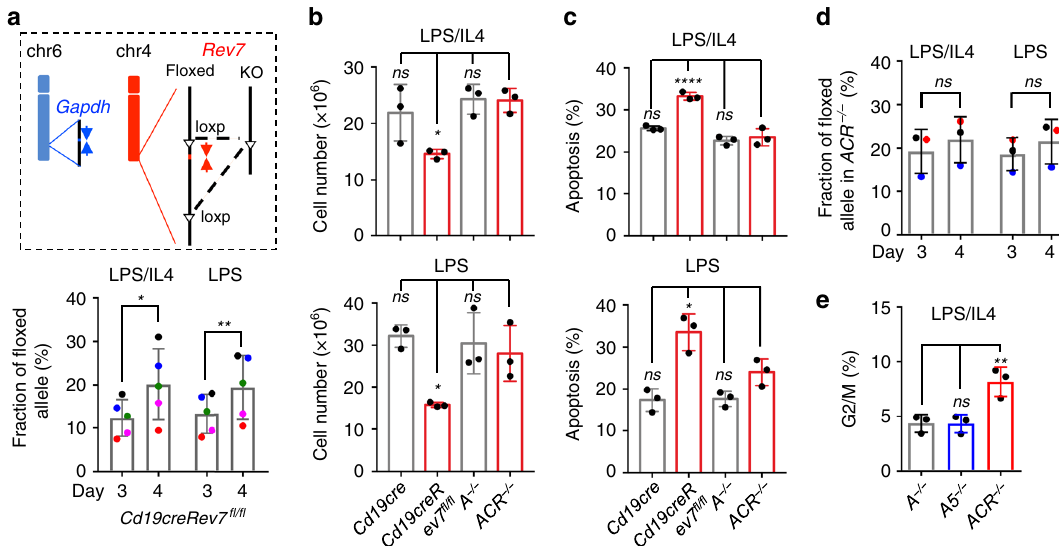
Fig. 4 AID de fi ciency rescues the cell death of REV7-de fi cient B cells in CSR. a Assessment of Rev7 deletion ef fi ciency. Schematic illustration of genotyping strategy of Rev7 - fl oxed allele (upper). Q-PCR primers are marks as arrows. A locus in Gapdh (chr6) was assayed as the loading control (blue arrows). Percentage of fl owed allele are shown for Cd19creRev7 fl / fl B cells at Day 3 and 4 after stimulation (lower). Colored dot indicates data from same mouse. n = 5 for each genotype, n represents independent mice. Cell numbers ( b ) and percentage of apoptotic population ( c ) upon LPS/IL4 (upper) or LPS (lower) are plotted. d Genotyping of indicated CSR-activated B cells. e Percentage of cells in G2/M phase is plotted for the indicated genotypes. A − / − : Aicda − / − , A5 − / − : Aicda − / − 53bp1 − / − , ACR − / − : Aicda − / − Cd19creRev7 fl / fl . n = 3 for each genotype in b – e and n represents independent mice. Data are represented as mean ± SD. Two-tail paired t -test was performed for a and d , and one-way ANOVA followed by Dunnett ’ s multiple comparisons test was performed for b , c , and e . ACR − / − mice are used as reference group in comparison for b , c , and e . ** p < 0.01, * p < 0.05, ns: p > 0.05. P -values and sample sizes are provided in Supplementary Table 2. Source data are provided as a Source Data fi